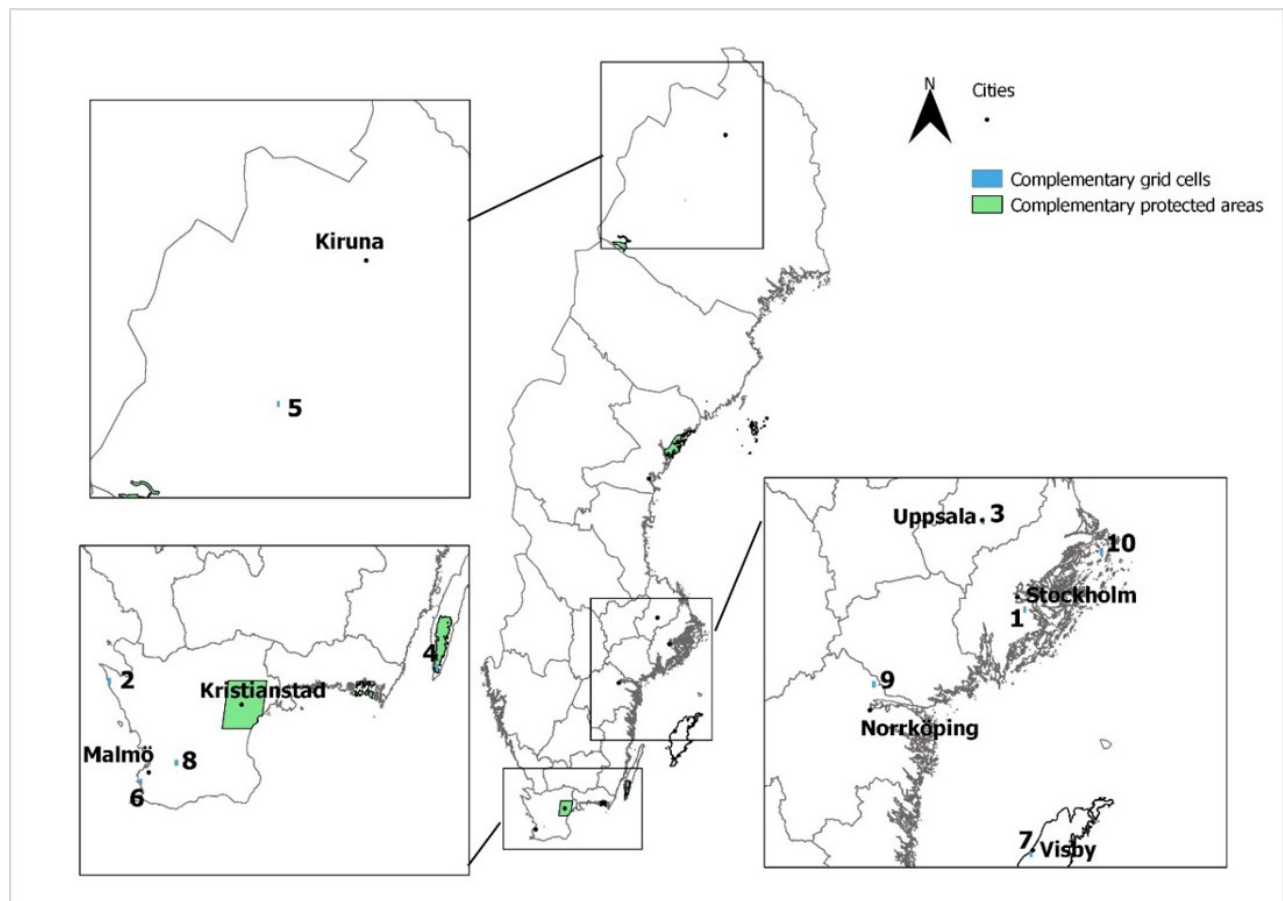
Figure 5. The protected area and grid cell complementary networks. The large black numbers on the map represent the priority grid cell locations and the blue areas are the complementary protected